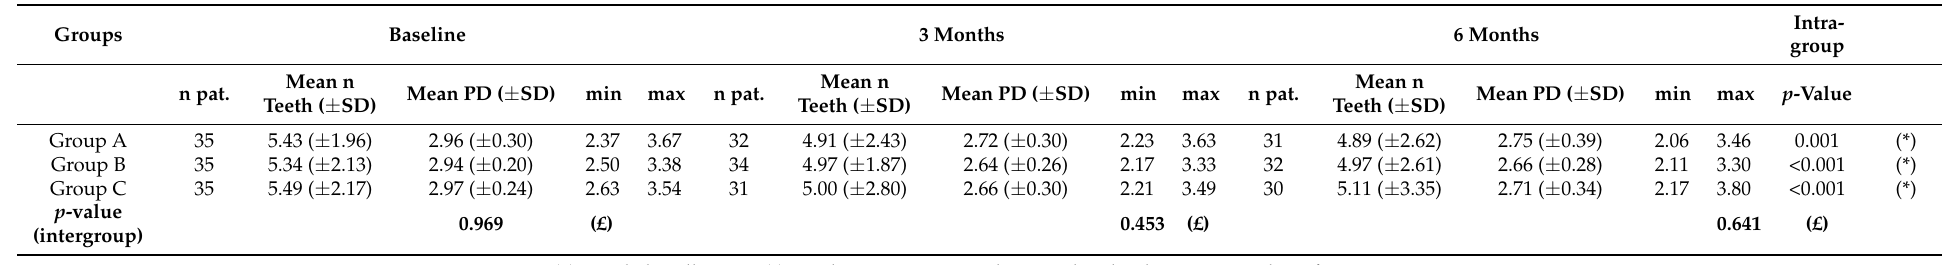
Table 4. Pocket probing depth (mm) ± SD per tooth in the three treatment groups (A: PDT, B: LDDs, C: control) at baseline and after 3 and 6 months. Groups Baseline